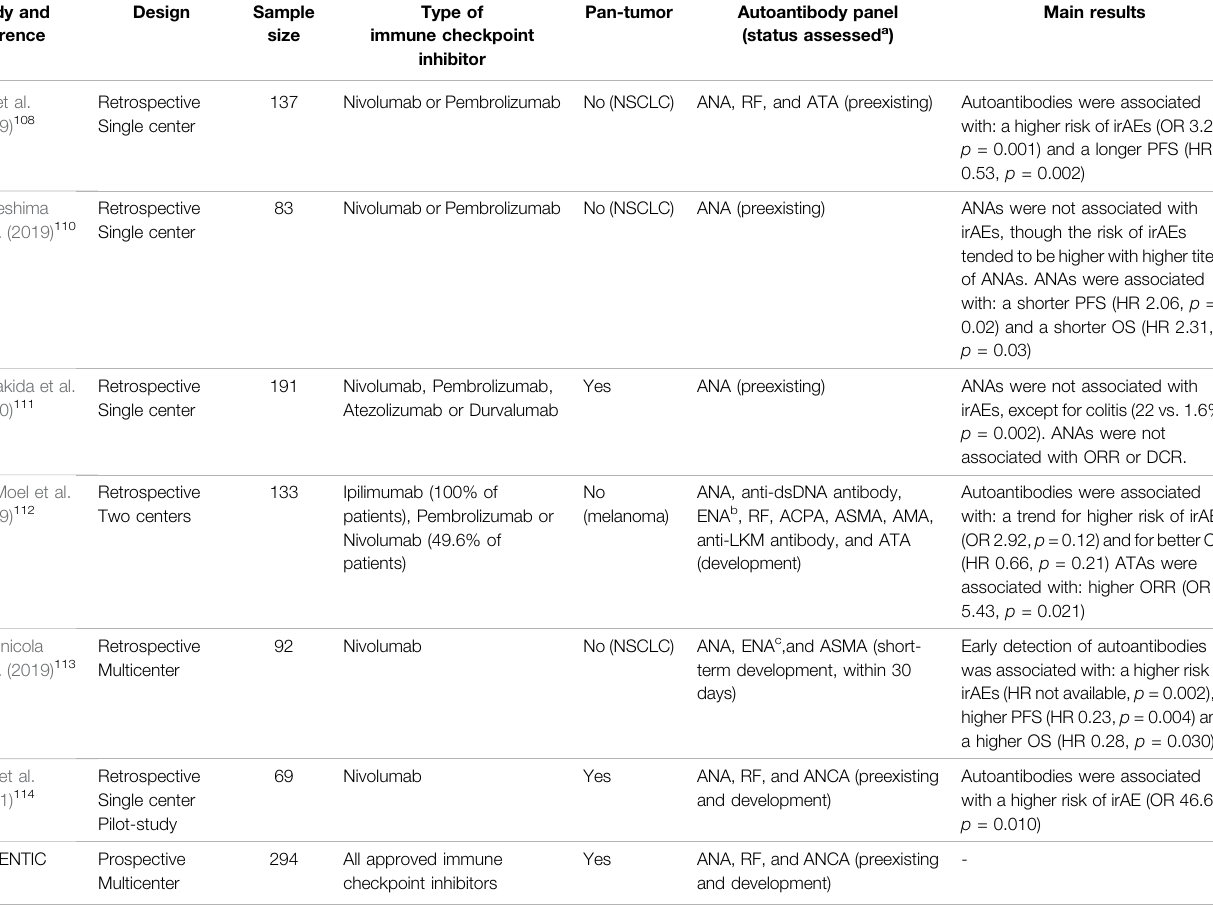
TABLE 1 | Summary of the studies assessing generic autoantibodies as predictors of immune-related adverse events in patients on immune checkpoint inhibitors. Study and